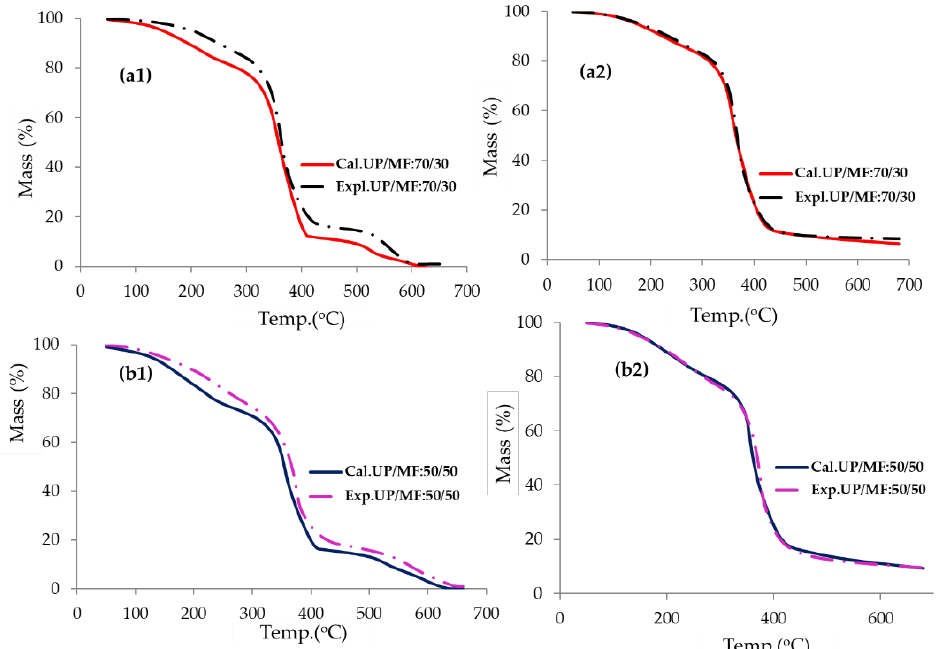
Figure 5. Experimental and calculated TGA curves for UP/MF:70/30 and UP/MF:50/50 cured resins in ( a1 , b1 ) air and ( a2 , b2 ) nitrogen.